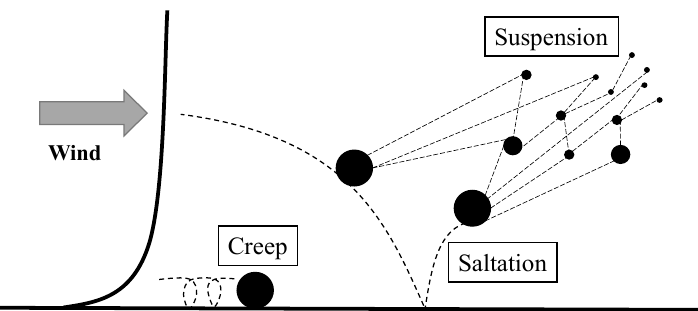
Figure 1. Transportation of sand particles by wind in a desert.